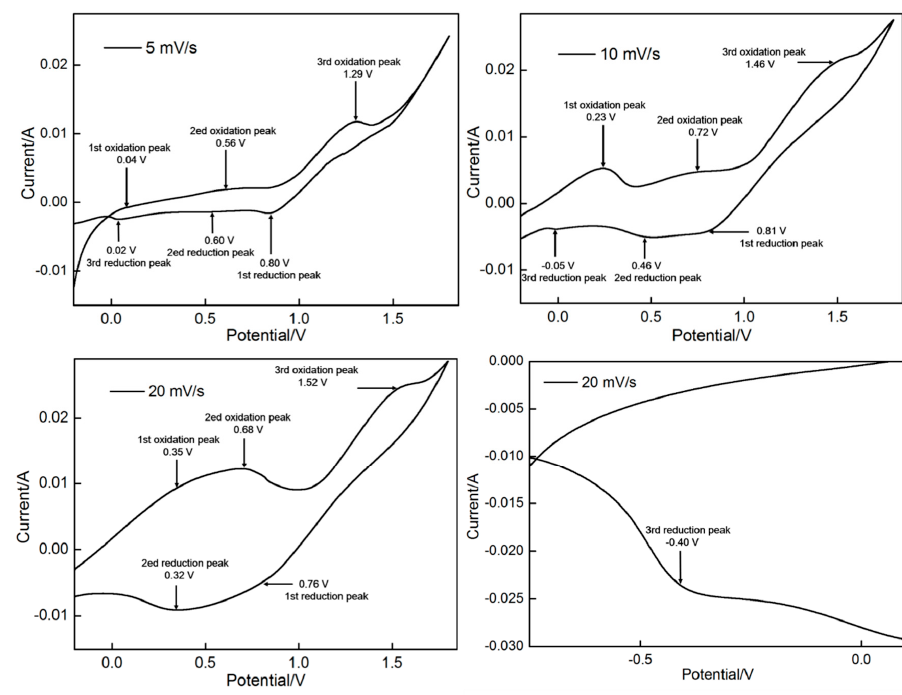
Figure 1. CV curves recorded on foam nickel.